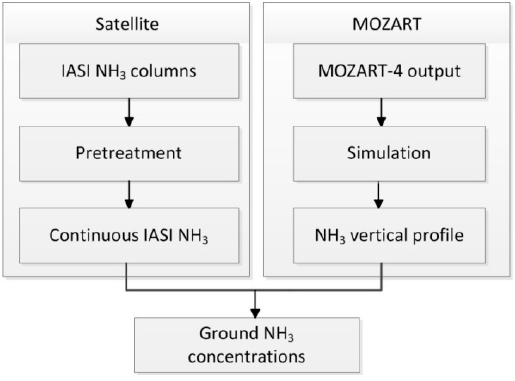
Figure 2 . Schematic of the method to estimate the satellite-derived ground NH 3 concentrations. Figure 2. Schematic of the method to estimate the satellite-derived ground NH 3